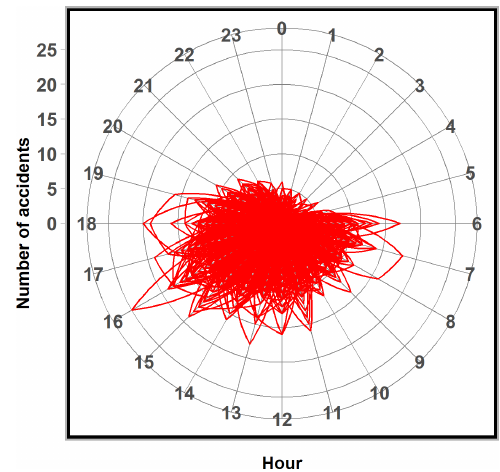
Figure 4: Chart showing the number of road traflc accidents in